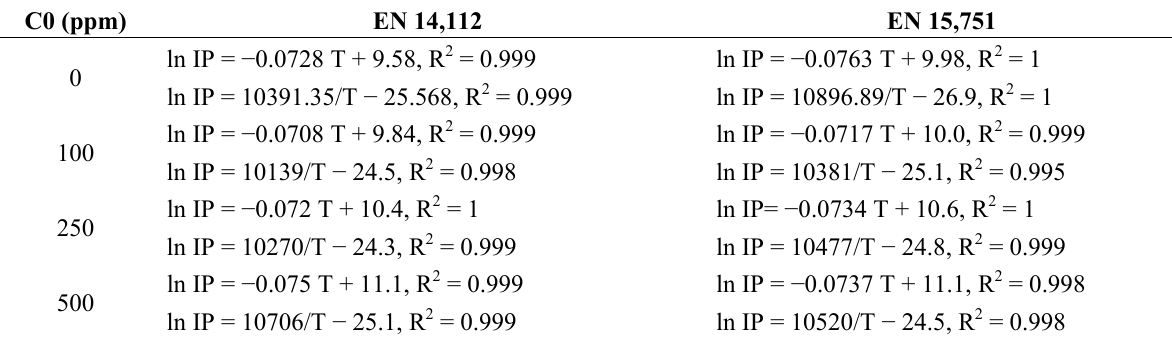
Table 4. The temperature-dependent correlations of ln IP for the SNME and FFA-based of PDA using EN 14,112 and EN 15,751. biodiesel blend stabilized with various C 0 C0 (ppm) EN